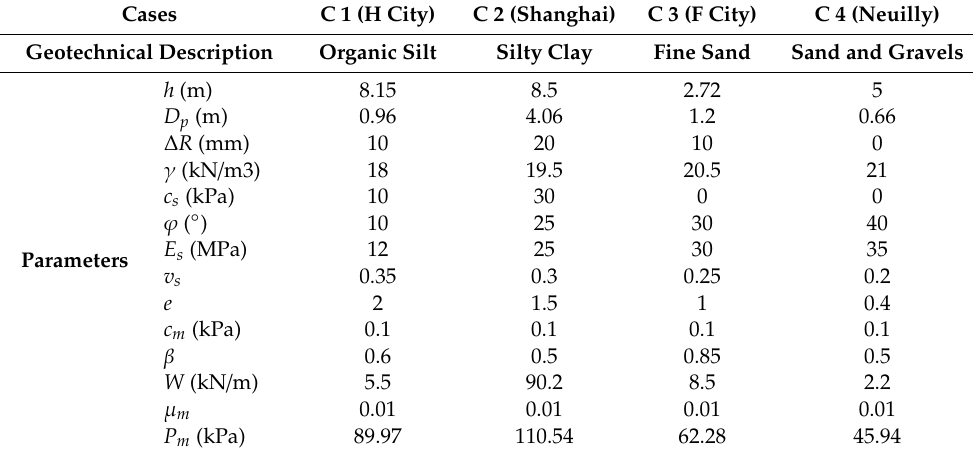
Table 4. Parameters that are needed to calculate the prediction equations in each case.